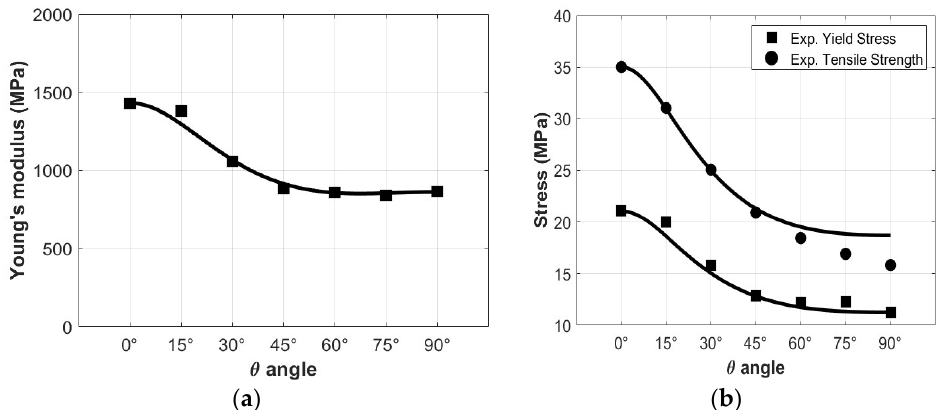
Figure 5. Comparison between experimental results (markers) and numerical predictions (continuous line) of Young’s modulus ( a ), yield stress and tensile ultimate strength ( b ) as a function of θ angle. Table 3. Compliance matrix coefficients. Table 2. Experimental results of tensile tests.